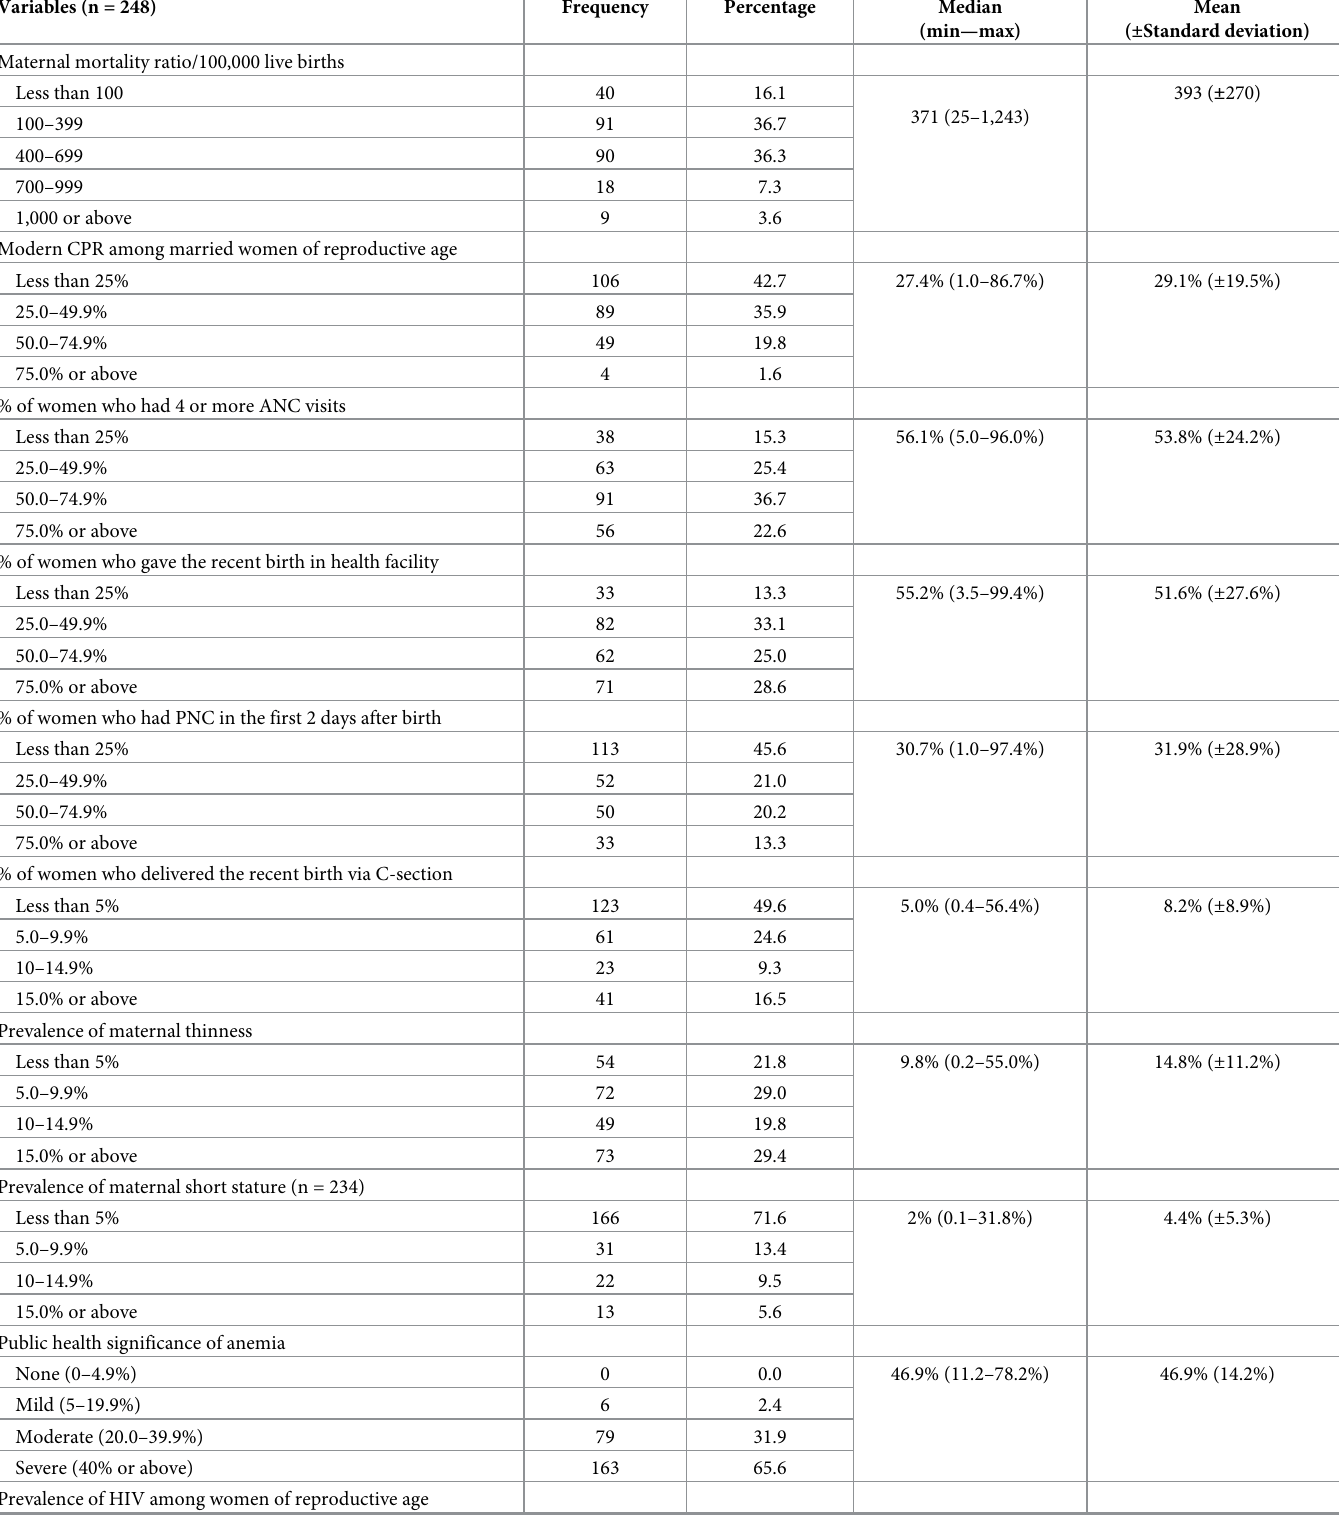
Table 2. Summary of the variables used in the model